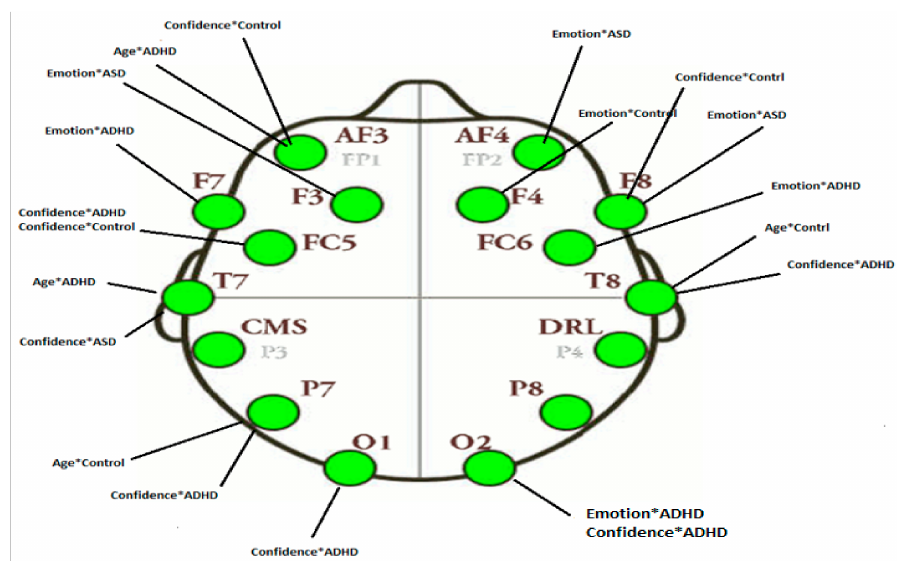
Figure 19. Location of intense behavior by group interaction effects (correlations >0.40), in both valid and invalid